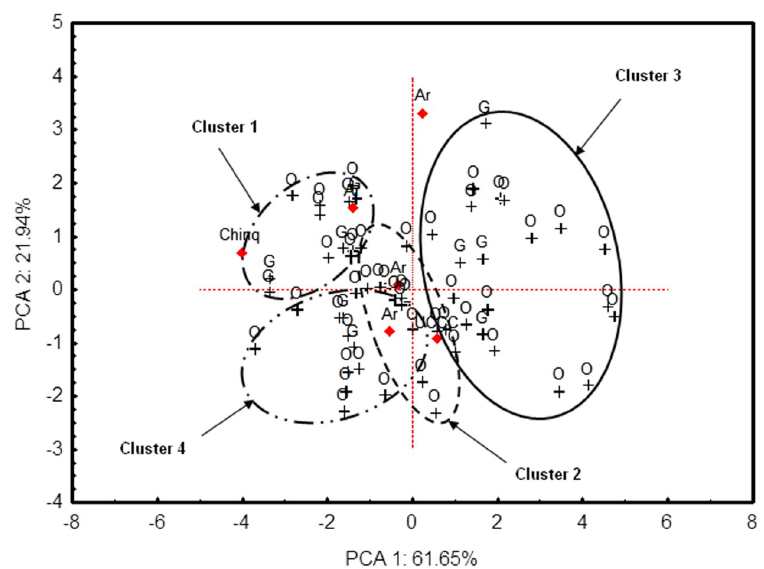
Fig 3. Projection of the hyperspace of morphological shell variability of non-indigenous C . dilatata onto the first two PC. Data points from a multidimensional vector space defined by seven linear and non-dimensional morphological shell variables and 59 individuals were plotted on the bi-dimensional space spanning the first two PCs of the PCA. PC 1 (= Factor 1) represented sex or overall size. Blue data points labelled with O and G correspond respectively to individuals collected from O Grove and El Arbeyal. The four ellipses with different line patterns plotted on the vector space delimit four clusters of data points obtained through the k-means clustering analysis. Each cluster represents a different shell morphotype. The cluster delimited by a continuous line includes mostly males, while the three clusters delimited by dotted lines include exclusively females. Red data points correspond to native specimens that were not used in the computation of the PCs but are projected onto the vector space for comparison.